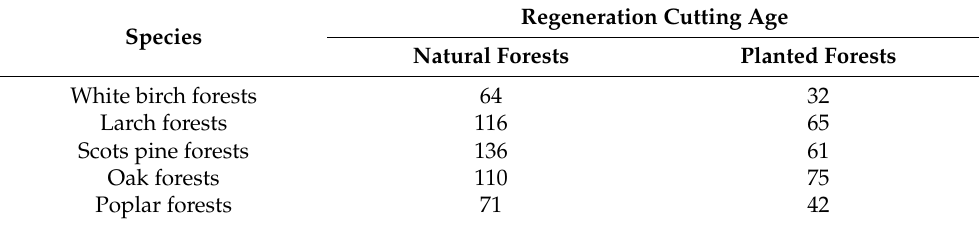
Regeneration Cutting Age Natural Forests Planted Forests